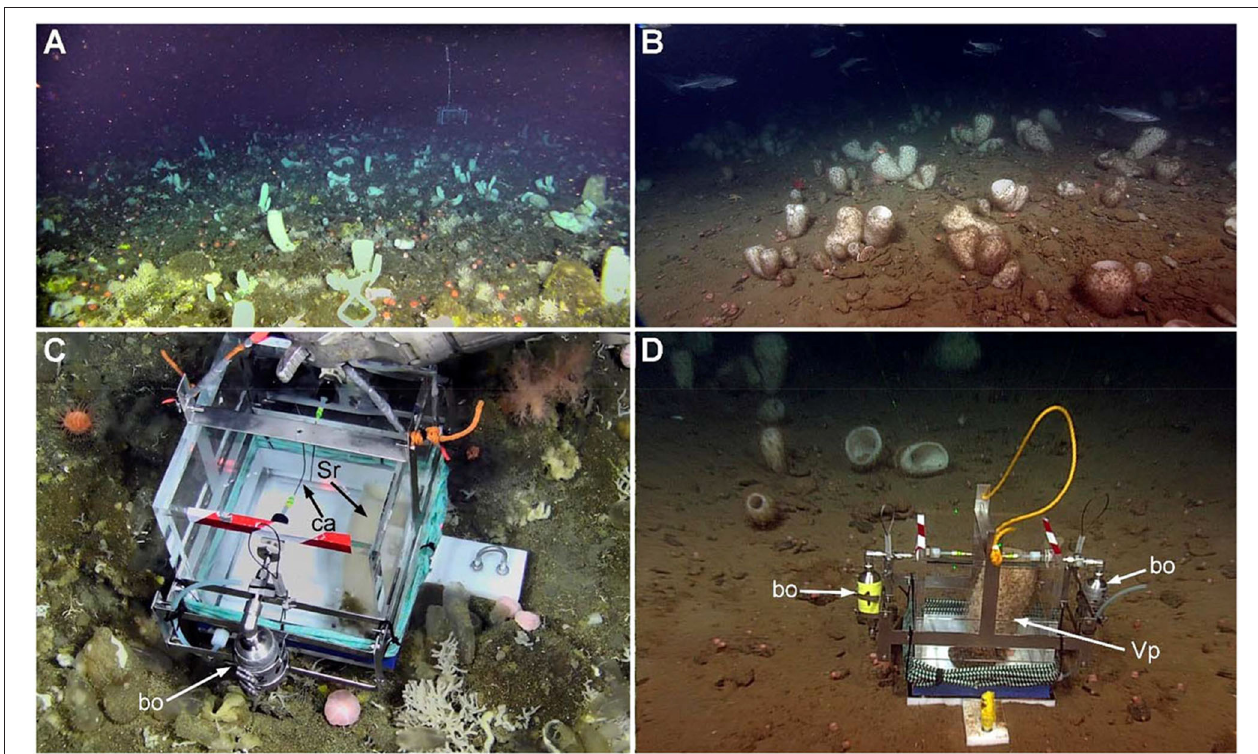
FIGURE 1 | (A) View of a multi-species sponge community at the Schulz Bank seamount (located between the Greenland and Norwegian Seas; 73.8 ◦ N; 7.5 ◦ E), where the whitish tubes of the hexactinellid Schaudinnia rosea co-dominate in abundance along with a variety of demosponges and small cnidarians. (B) View of the monospecific aggregations of the hexactinellid Vazella pourtalesii that extend on the deep region of the continental shelf in Nova Scotia (Canada). (C,D) In-situ incubation of an individual of Schaudinnia rosea (Sr) and a Vazella pourtalesii (Vp) in their respective natural communities at depths of 580 and 180m, respectively. Note that the incubation chambers incorporate two external steel bottles (bo) for water sampling within the camera by means of capillaries (cp) that pierce the chamber